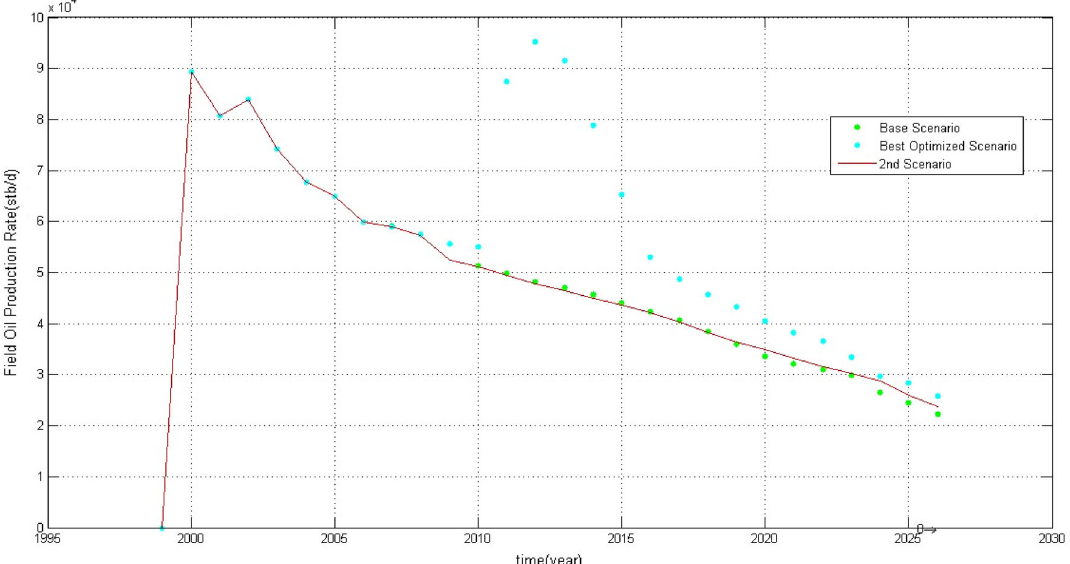
Fig. 5 Field production rate of second